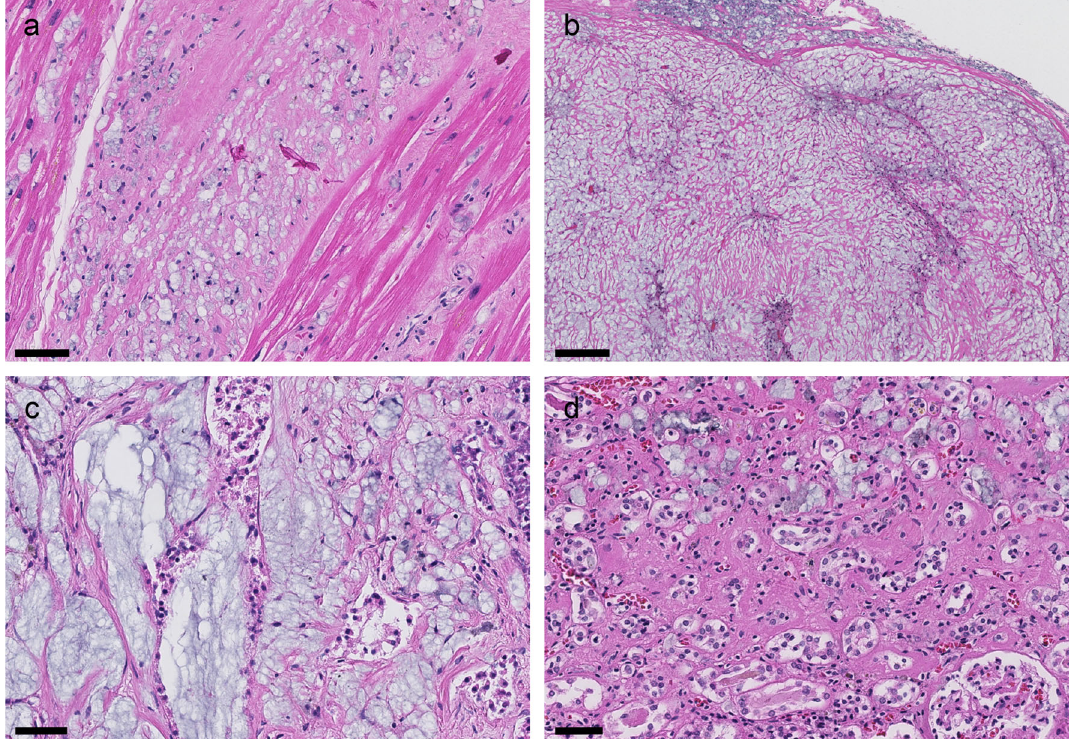
Figure 4. Autopsy findings (H&E). Infiltrates of histiocytes with the bluish vacuoles characteristic of PVP in all organs. (a) Myocardium: Interstitial fibrosis and histiocytic infiltrates. Scale bar 50 μ m. (b) Pleura: Nodular lesion composedoffibrotictissueandhistiocytes.Wefoundsimilarlesionsinthepericardiumandperitoneum.Thesewere macroscopically visible. Scale bar 200 μ m. (c) Pancreas: Pronounced fibrosis with histiocytic infiltrates. Poorly preserved ductal structures. Scale bar 50 μ m. (d) Kidney: Cortical tissue showing interstitial fibrosis, tubular atrophy, and an infiltrate of histiocytes in the extended interstitium. Scale bar 50 μ